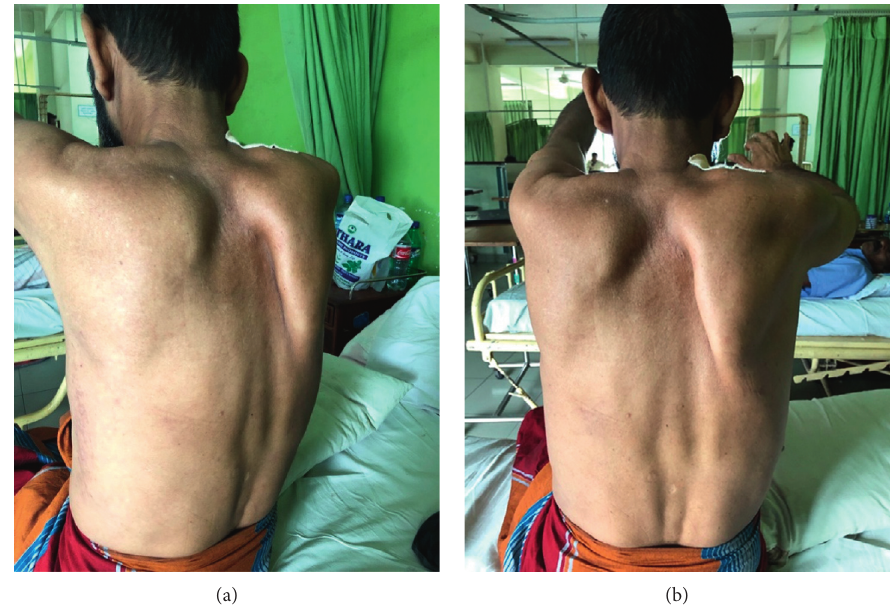
Figure 1: Winging of scapula. (a) Winging of the right scapula posteriorly (lateral view). (b) Winging of the right scapula (posterior